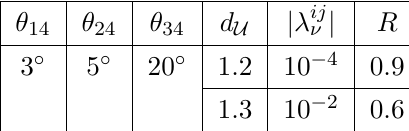
Figure 4 . The variations of the neutrino induced upward going muons per year from the GRB with (a) di(cid:11)erent values of d U for four di(cid:11)erent (cid:12)xed values of j (cid:21) ij j as well as for the mass (cid:13)avour (cid:23) case (no decay case), (b) di(cid:11)erent values of j (cid:21) ij j for four di(cid:11)erent (cid:12)xed values of the unparticle (cid:23) dimension d U (1.1, 1.2, 1.3, 1.4) and in addition for no decay case. See text for details.